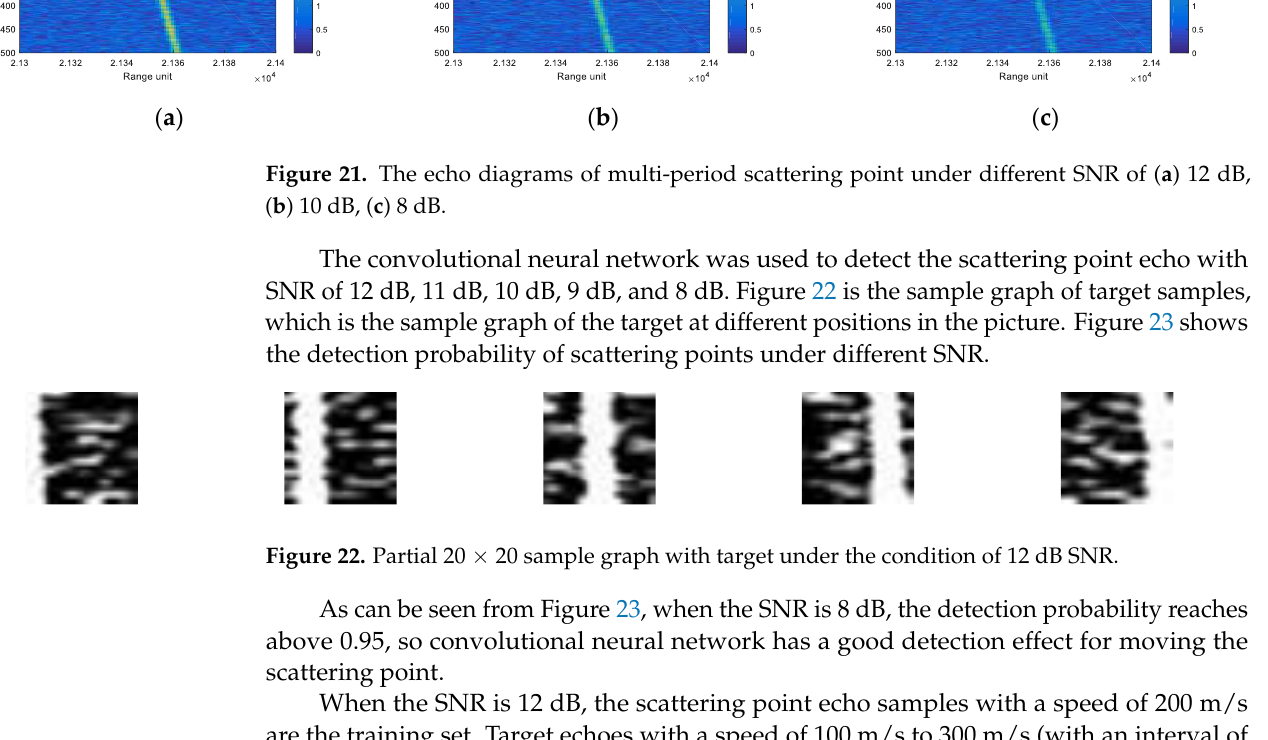
Figure 23. Detection probability diagram of scattering point under different SNR. As can be seen from Figure 23, when the SNR is 8 dB, the detection probability reaches above 0.95, so convolutional neural network has a good detection effect for moving the scattering point.